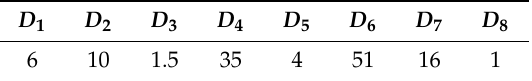
| with three di ff erent feeding sheets. 11